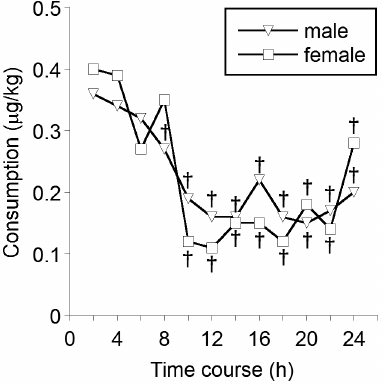
Figure 1. Differences in the time course of fentanyl adminis- tration between males and females. Main effects, interactions, and differences within time courses were analyzed using mixed-design ANOVA (one-way for independent groups and repeated-measures with Huynh-Feldt correction). The values indicate the medians. { P , 0.05, compared with fentanyl consumption in the first 2